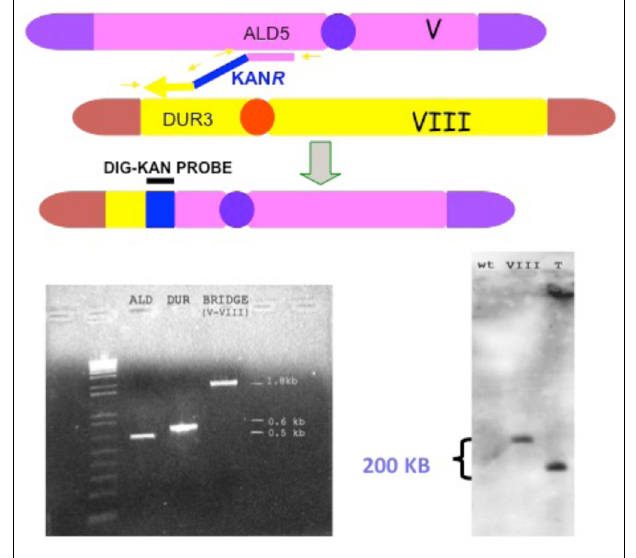
FIGURE 3 | Schematic representation of a BIT chromosome translocation event induced in the yeast S. cerevisiae , and its molecular verification by PCR and Southern blot analysis. BIT translocation designed between the ALD5 locus on chromosomeV and DUR3 on chromosomeVIII and obtained by transformation with a linear double-stranded DNA cassette having the two extremities homologous to the two loci , flanking the positively selectable marker KAN R .The translocation between the two top chromosomes, catalyzed by the DNA cassette functioning as a bridge, produces the translocated chromosome below the big gray arrow.Verification of the correct chromosome translocation by gel electrophoresis analysis of PCR amplification (bottom, left) of the two DNA junctions at the ALD5 and DUR3 loci (between primers indicated by the two small yellow arrows on the right and the left, respectively), lanes ALD and DUR of the gel.Verification of the formation of the DNA bridge between the two chromosomes by PCR amplification of the region between the two external primers indicated by the two small external yellow arrows, lane BRIDGE of the gel. Bottom, right: Southern hybridization with a DNA probe corresponding to the KAN R gene, of a contour-clamped homogeneous electric field (CHEF) electrophoresis spread of chromosomes from a wild-type strain (lane wt), a strain with chromosomeVIII previously marked with KAN R (laneVIII) and a strain subjected to BIT translocation at the same loci